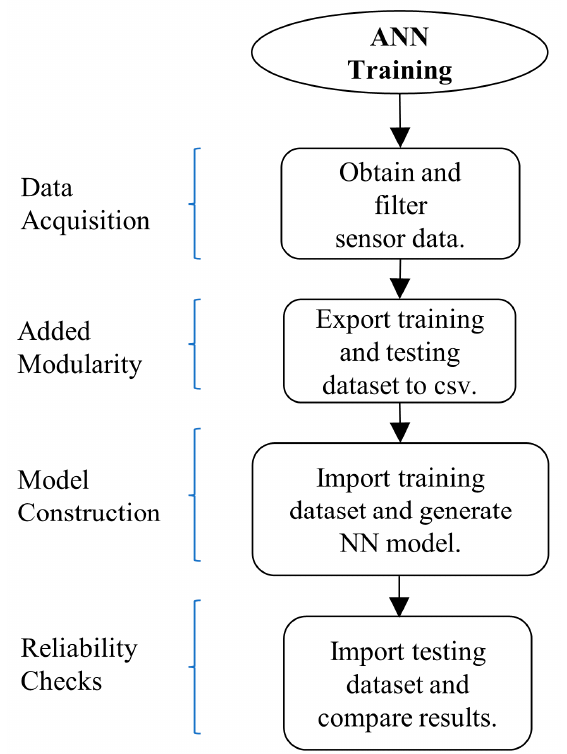
Figure 11. The neural network training stage.